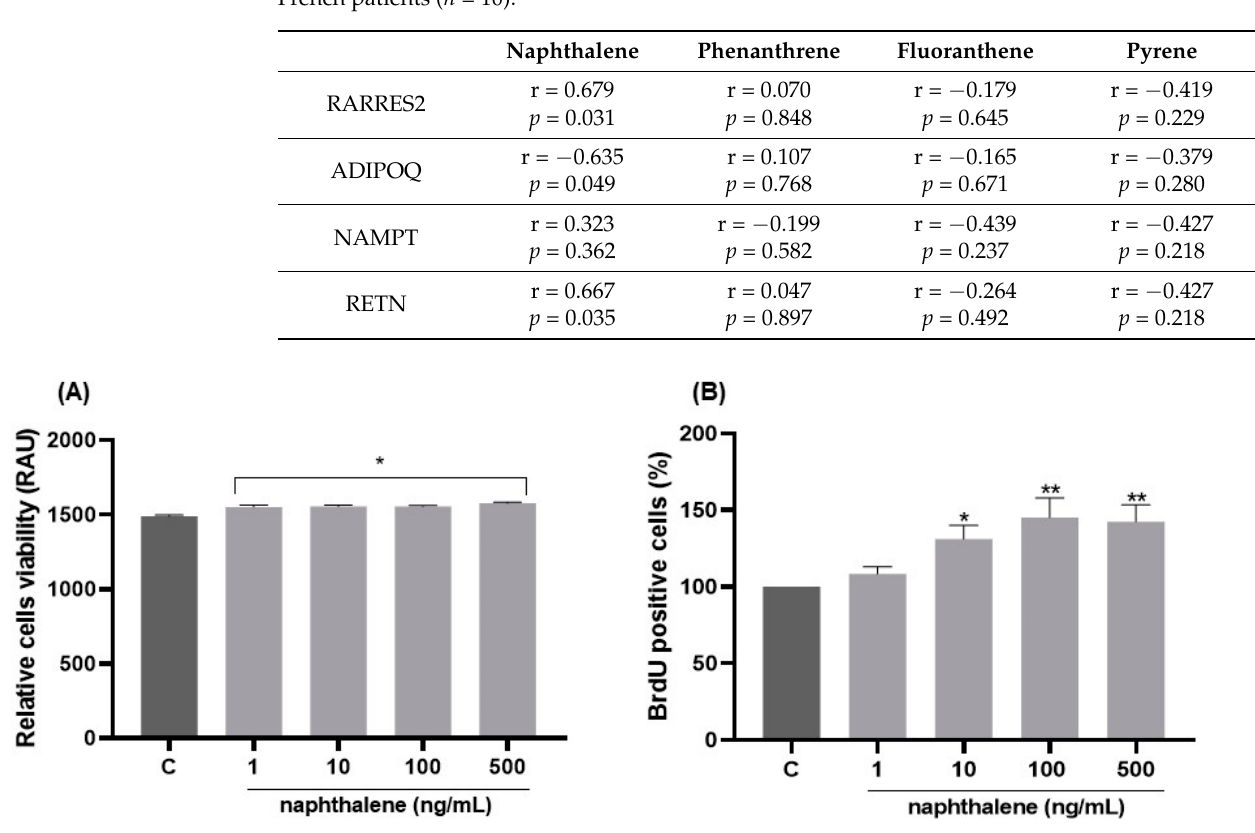
Figure 2. Dose-dependent effect of naphthalene on cell viability ( A ) and proliferation ( B ) of 3T3-L1 preadipocytes. 3T3-L1 preadipocytes were incubated without or with naphtalene in different concentrations for 24 h. For BrDU-positive cells, results were normalized to a percentage of control. Values are expressed as mean ± SEM ( n = 7). * p < 0.05, ** p < 0.01 vs. control.